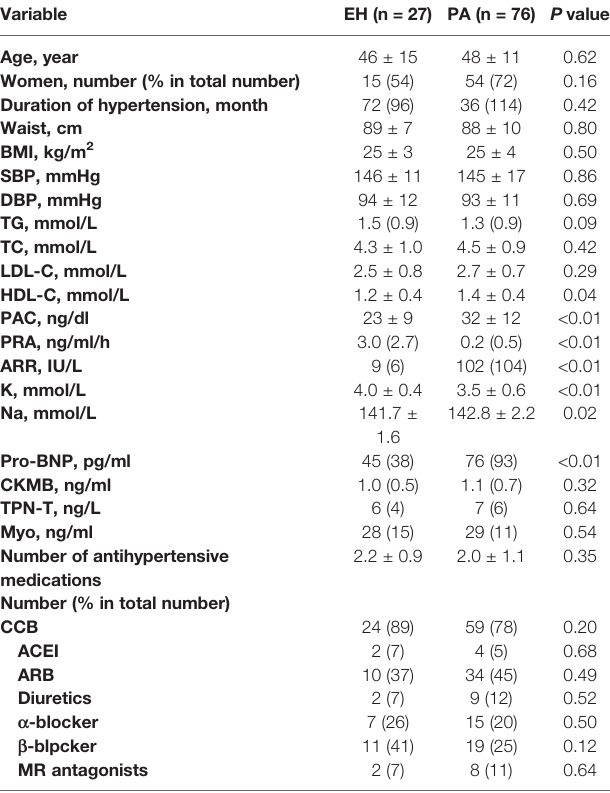
TABLE 1 | Demographic characteristics and laboratory data of patients. Variable